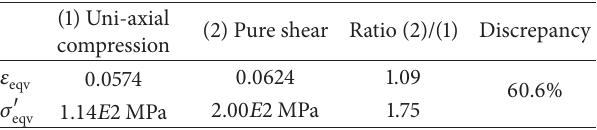
Figure 5: A unit cell FEM mesh (one-eighth model of the unit cell in Figure 4(a)).